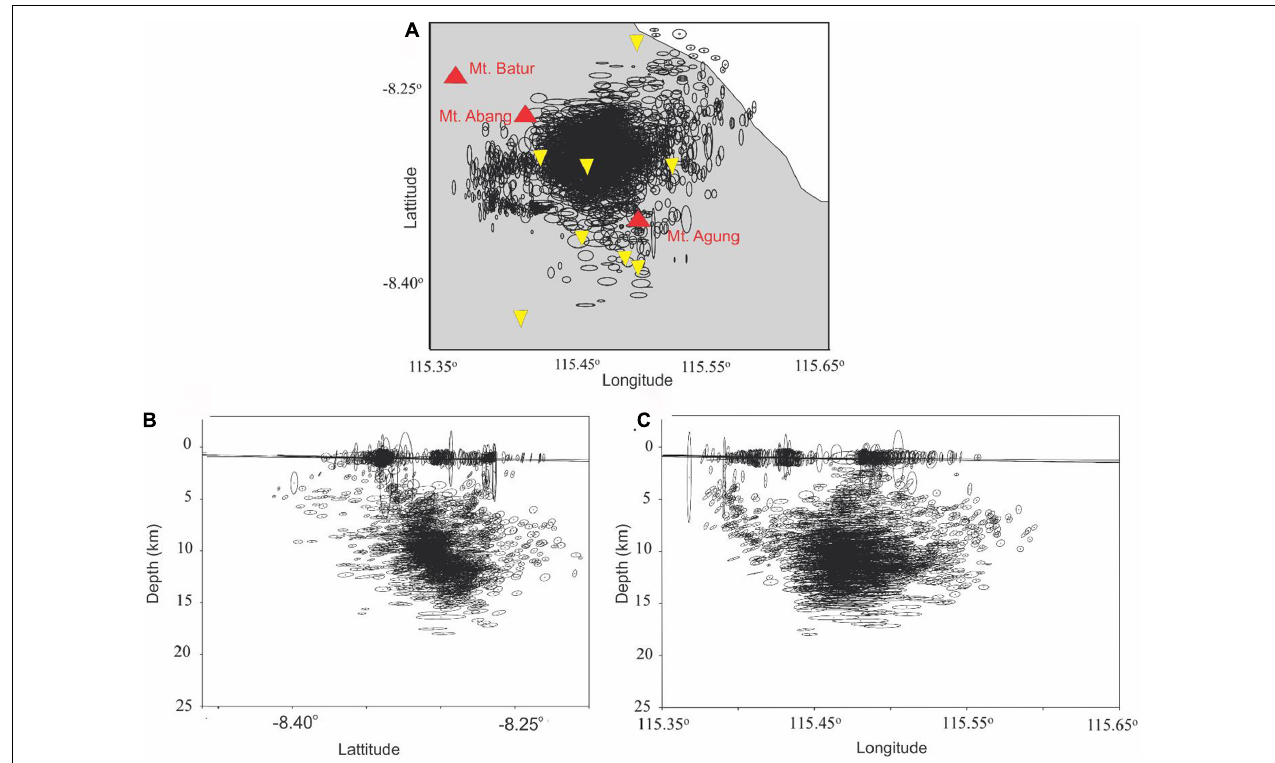
FIGURE 11 | The relative location errors for the relocated VT events of 2017 Agung volcanic eruption in (A) map view, (B) vertical cross-sections along latitude, and (C) vertical cross-section along longitude. Each ellipsoid represents 95% confidence obtained from a bootstrap analysis of the final double-difference vector. Red triangles show Agung, Abang, and Batur volcanoes. Yellow inverted triangles indicate the seismic